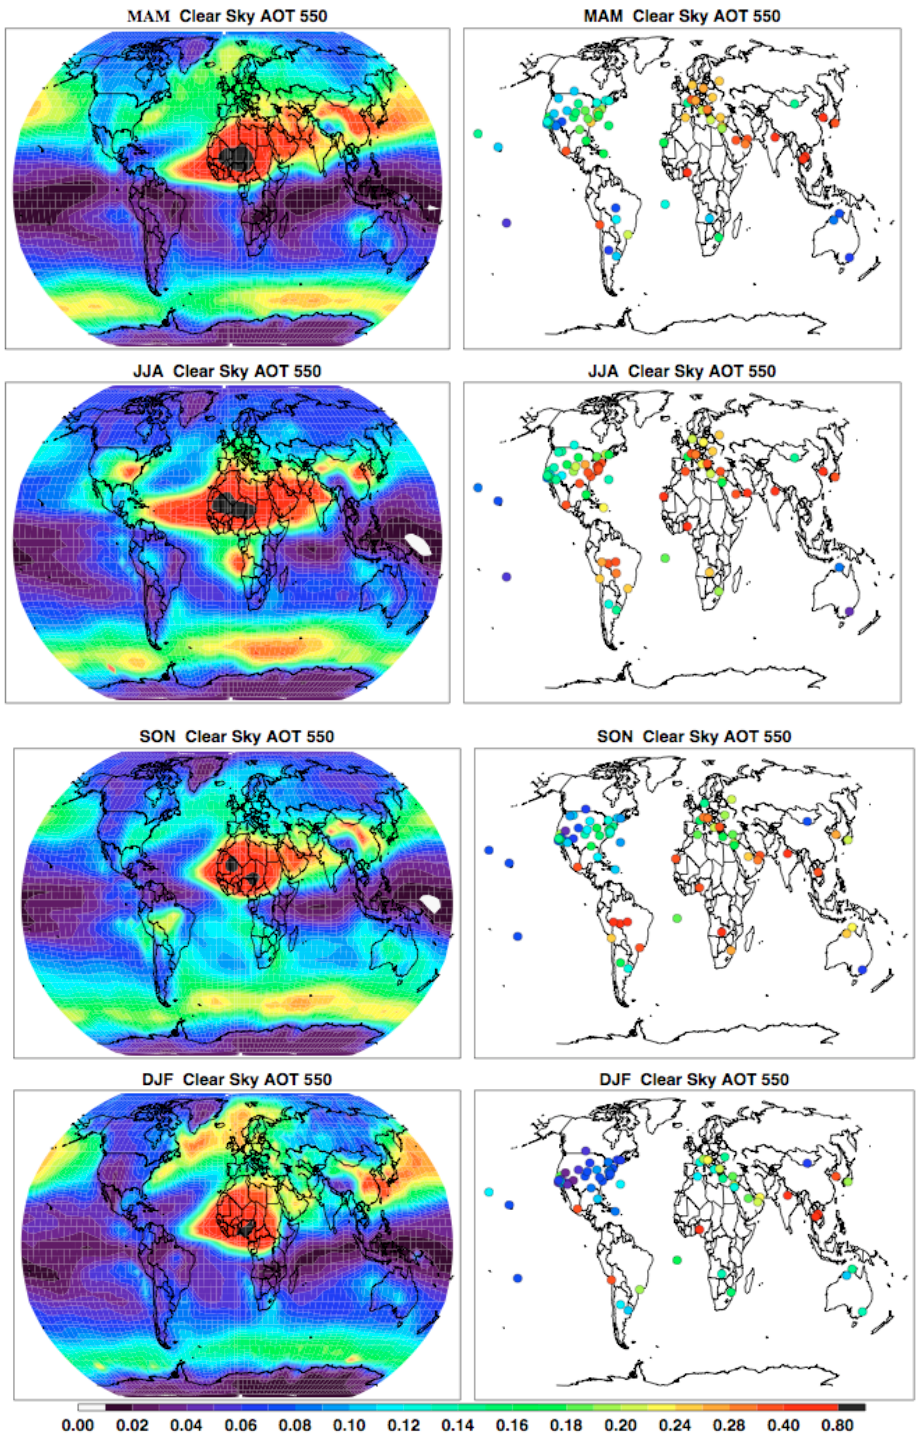
Fig. 6. Aerosol optical thickness at 550nm for clear sky conditions shown for the four seasons. Left column shows model data and the filled circles in the right column give the AERONET data.